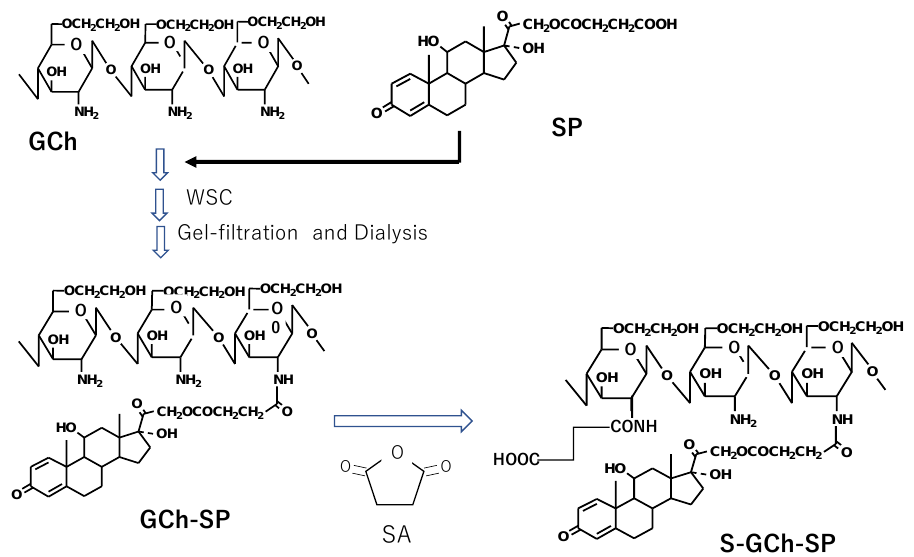
Figure 1. Synthetic scheme of GCh-SP and S-GCh-SP. GCh: glycol-chitosan, SP: succinyl-prednisolone, GCh-SP: GCh-SP conjugate, S-GCh-SP: succinylated GCh-SP, WSC: water-soluble carbodiimide, SA: succinic anhydride.